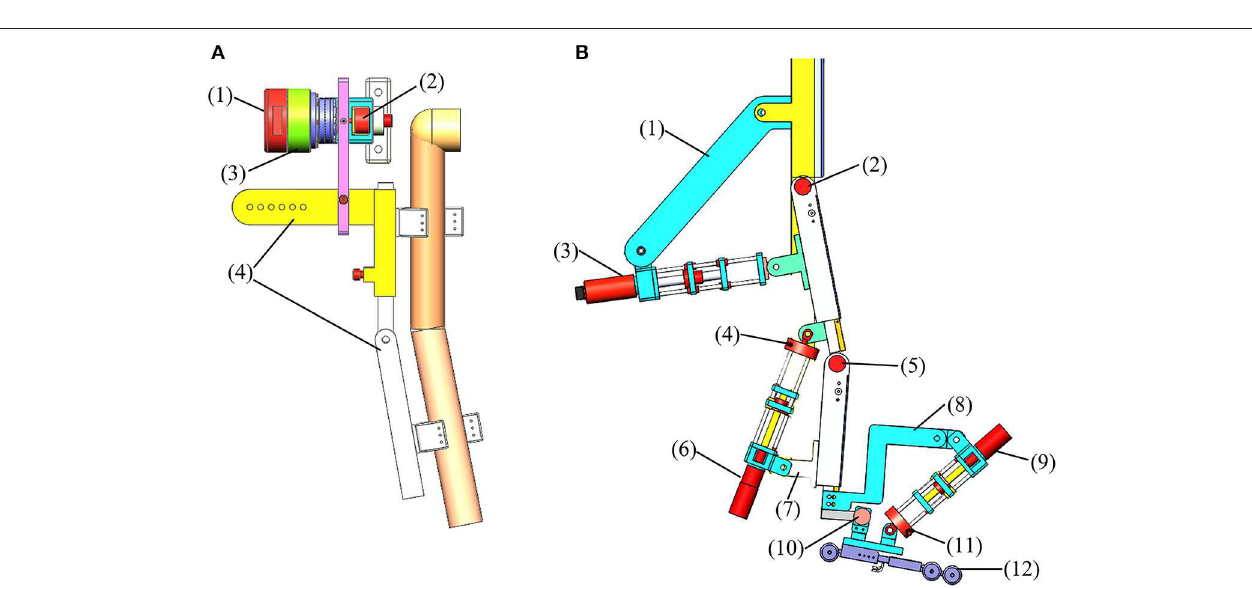
FIGURE 2 | The models of the mechanisms for the right upper and lower limbs. (A) Upper limb model: (1) shoulder motor (EC 90), (2) angle sensor, (3) gearbox (ratio of 100:1), and (4) shoulder adjusting bars. (B) Lower limb model: (1) hip assisting bar, (2), (5) and (10) angle sensor, (3) hip motor (RE 50), (4) and (11) force sensor, (6) knee motor (RE 40) with a gearbox (ratio of 3.5:1), (7) knee assisting bar, (8) ankle assisting bar, (9) ankle motor (RE 40), and (12) shoe